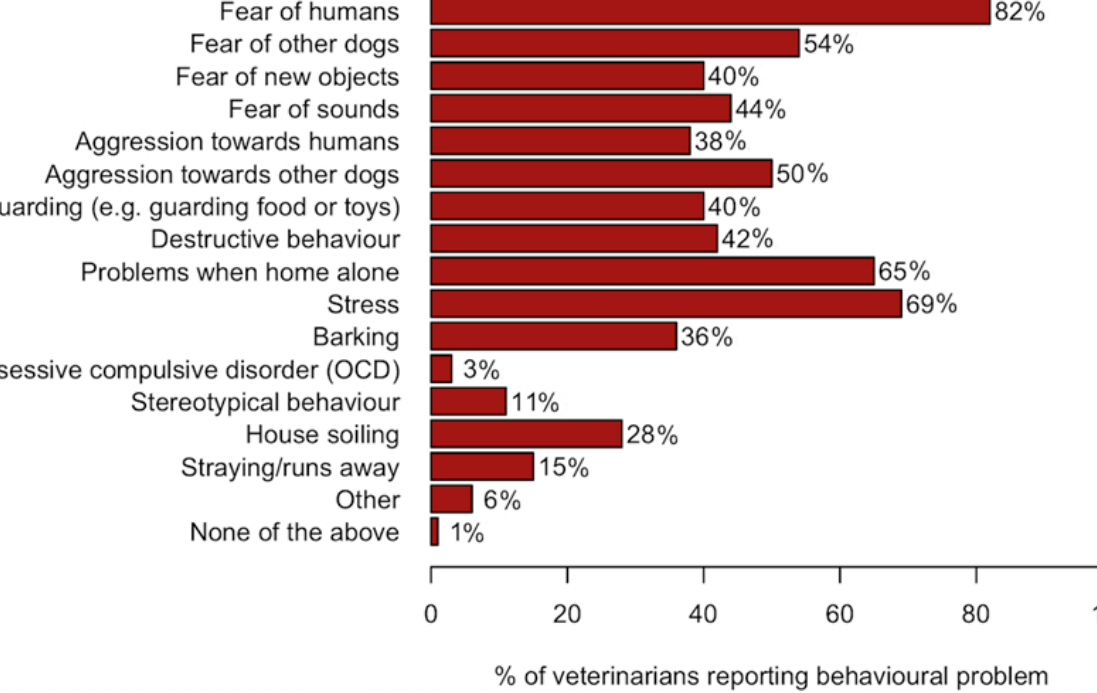
Figure 1. For the 15 listed behavioural problems, the percentages of veterinarians ( n = 173) reporting that they had seen the problems in former street (FS) dogs.